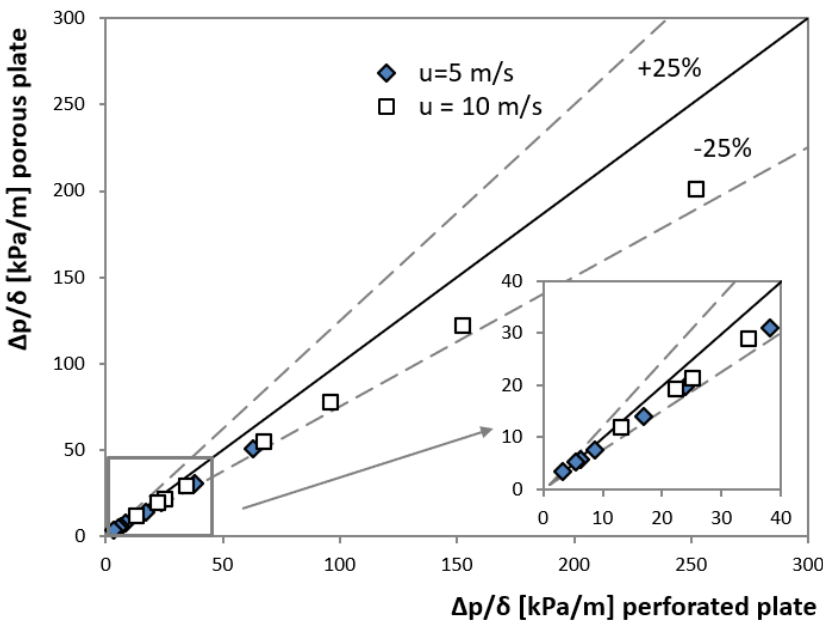
Figure 9. Comparison of pressure drop per depth of the plate for perforated and porous plates for all tested plates and two average velocities of air.